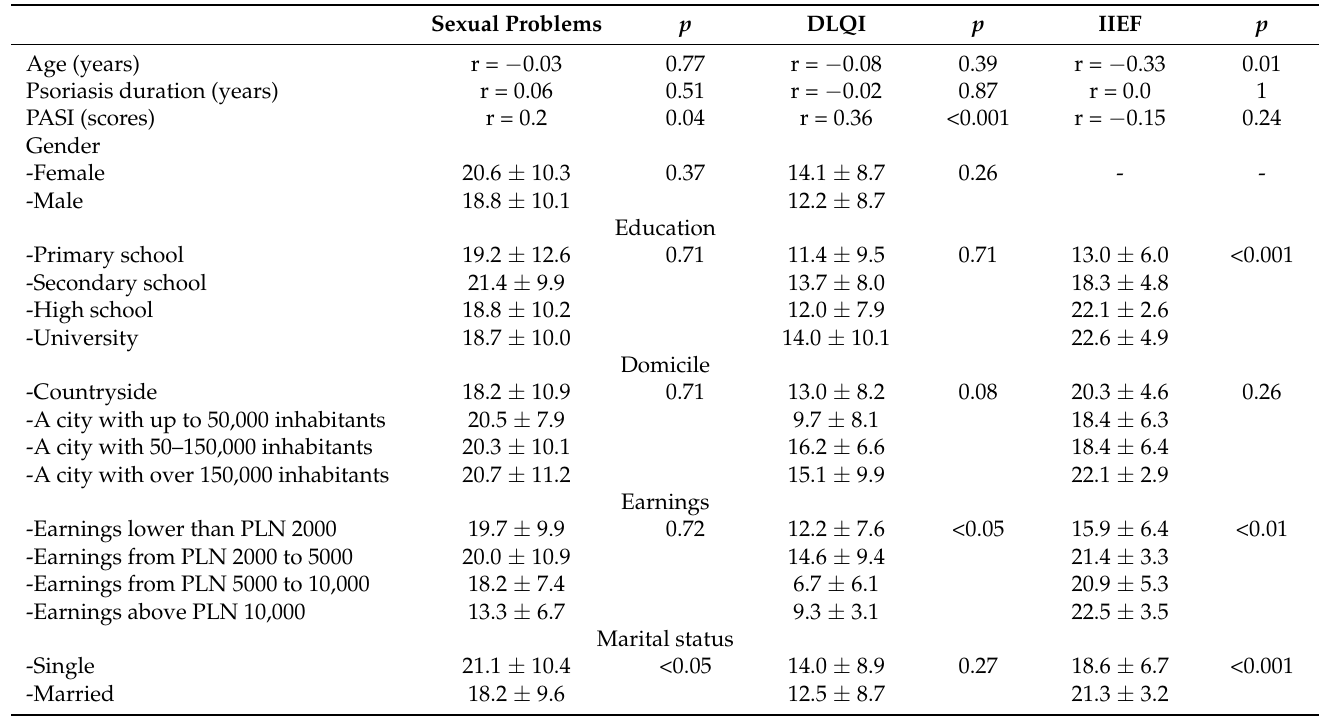
Table 4. The influence of clinical and demographic parameters on sexual problems, quality of life and erectile dysfunction among studied patients with psoriasis (DLQI—Dermatology Life Quality Index, IIEF—International Index of Erectile Dysfunction, PASI—Psoriasis Area and Severity Index, PLN—Polish